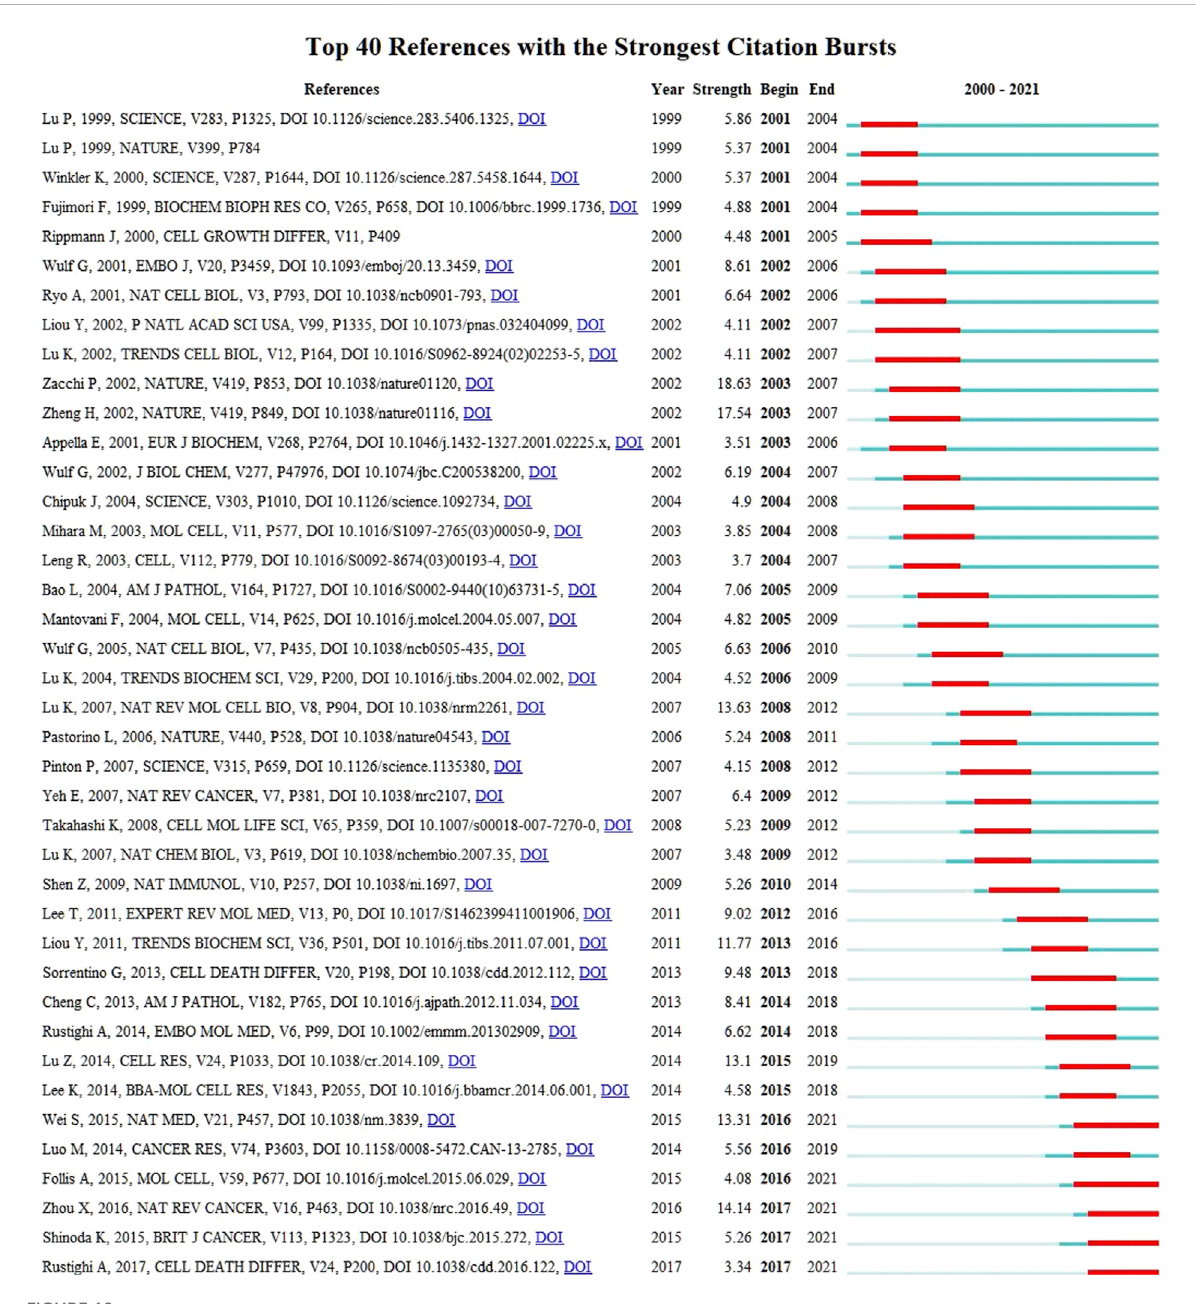
FIGURE 10 CiteSpace visualization map of top 40 references with the strongest citation bursts. A variable experiencing large changes in a short period of time indicates a strong burst of citations, and the red bar indicates the duration of the burst.